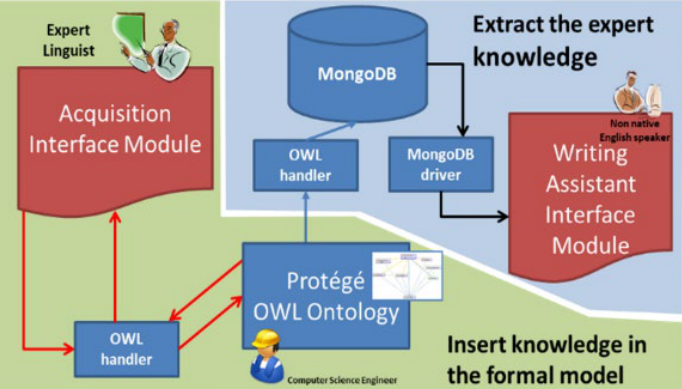
Figure 2. O-WEAA: Ontology-Writing English Assistant Architecture general